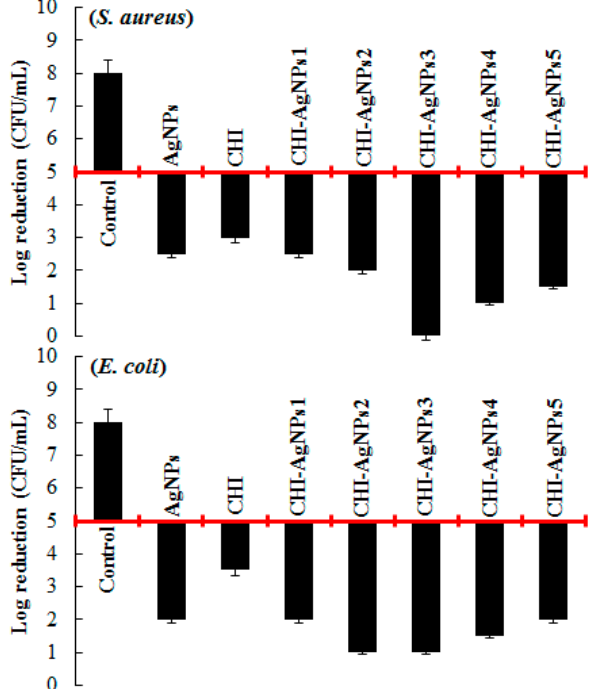
Figure 4. The antibacterial potentialities of pristine Convolvulus arvensis AgNPs and GA-assisted AgNPs loaded CHI-AgNPs conjugates against the Gram-positive bacterial strain, i.e., S. aureus and Gram-negative bacterial strain, i.e., E. coli . Due to the intrinsic variability of the antibacterial test results, at least a 2-log reduction was considered necessary to claim antibacterial activity.